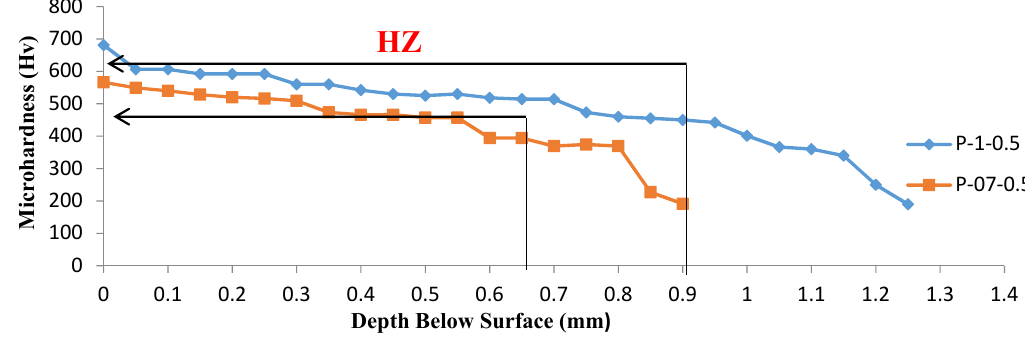
Figure 13. The microhardness profiles of laser treated samples processed at two different laser powers (700 and 1000 W) at a constant laser scanning speed of 0.5 m ∙ min − 1 .